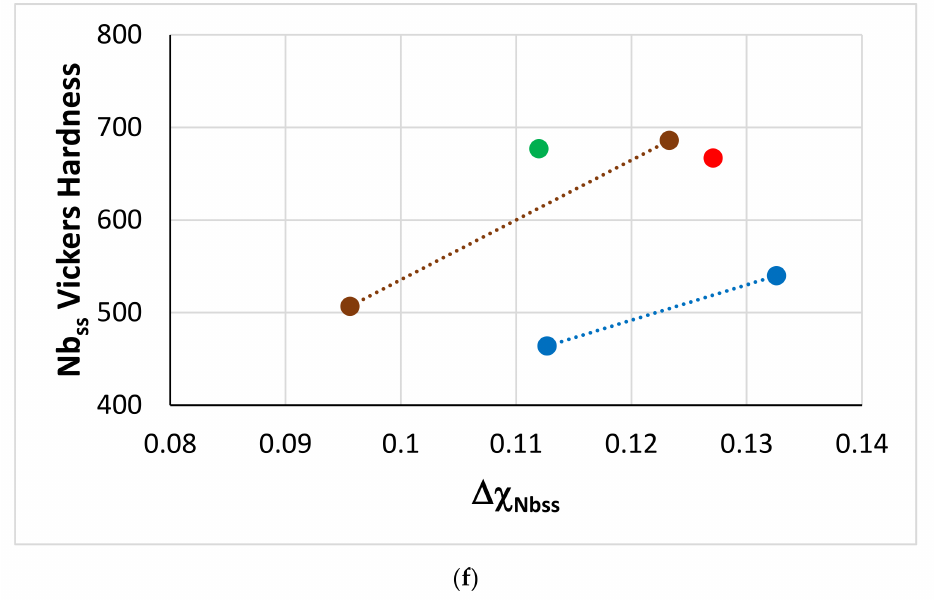
Figure 21. Hardness of ( a ) alloys, ( c ) Nb 5 Si 3 , ( d ) A15-Nb 3 X, ( e ) and ( f ) Nb ss , and ( b ) room- temperature-specific strength of the alloys of this work versus ( a – c ) the alloy parameter VEC, ( d ) the parameter ∆ χ of the A15-Nb 3 X, and ( e ) the parameter δ and ( f ) the parameter ∆ χ of Nb ss . In ( e ), the R 2 value is for the data for the alloys EZ2 and EZ6, where the Nb ss is a stable phase. Colors as follows: blue alloy EZ2, red EZ5, brown EZ6, and green EZ8. In ( a – f ), the dotted line is to “guide the eye”. The hardness of the A15-Nb 3 X increased with its parameter ∆ χ and was higher for the alloys EZ5 and EZ8 (Figure 21d). The hardness of the Nb ss increased with its parameters δ and ∆ χ (Figure 21e,f). The trend in Figure 21f is in agreement with previous work for RM(Nb)ICs and RM(Nb)ICs/RCCAs [3]. Compared with the alloy EZ2, the addition of Al and/or Cr in EZ5, EZ6, and EZ8 increased the hardness significantly. The hardness was highest for the as-cast alloys EZ5, EZ6, and EZ8.